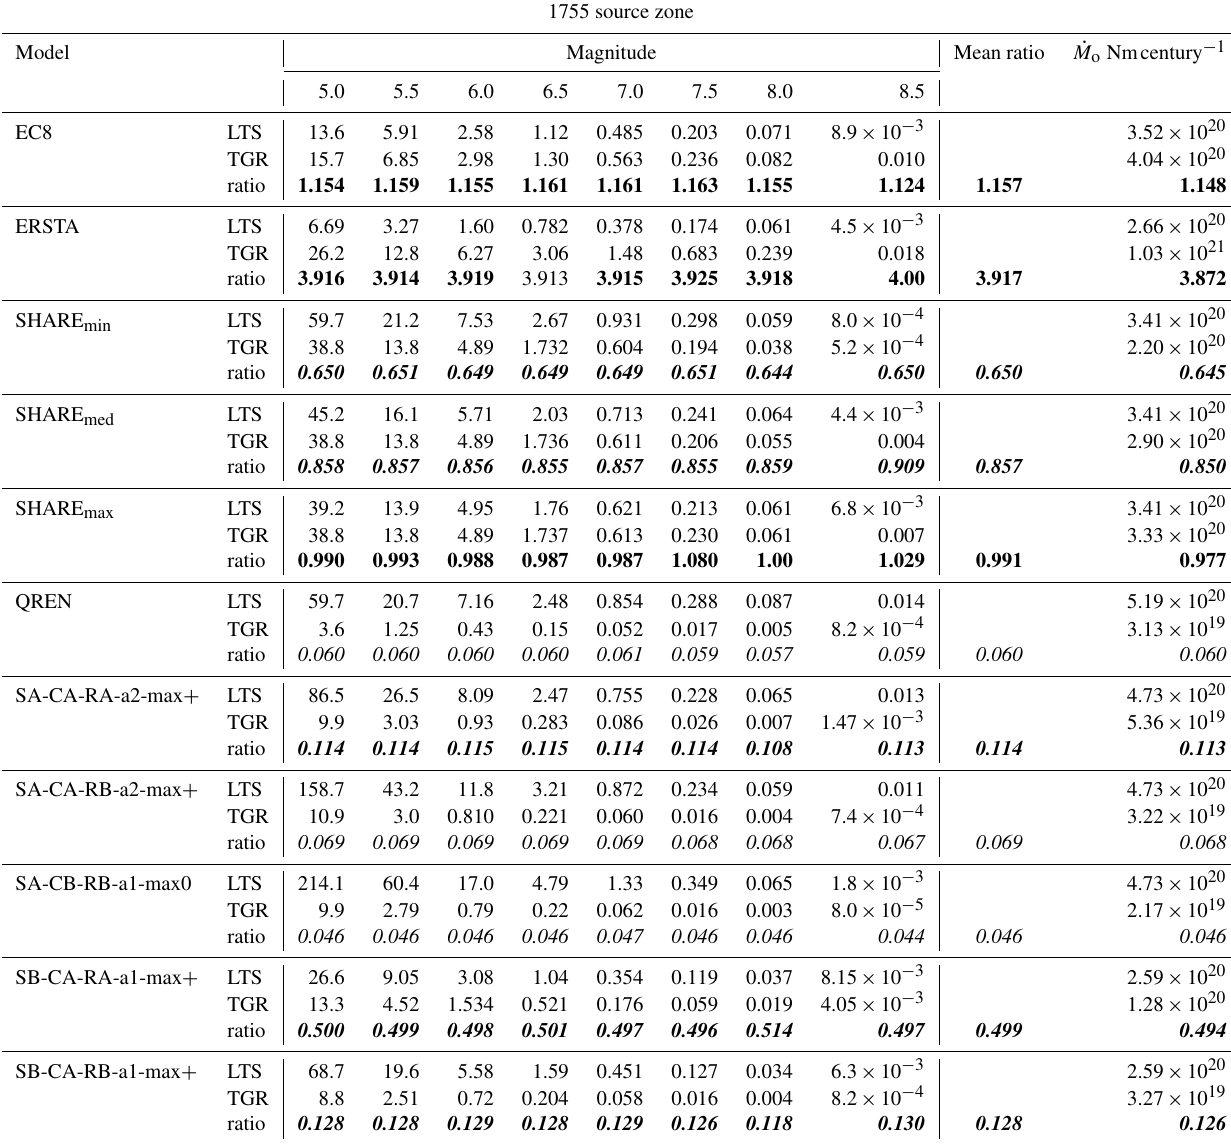
Table 11. Complex test: activity rates in earthquakes per century for the 1755 source zone. Two sets of seismicity parameters were used: (1) LTS obtained with the long-term seismicity program and (2) PSHA models expressed as tapered Gutenberg–Richter laws (TGR). Ratio represents the ratio between TGR and LTS. The number of earthquakes consider a catalogue period of 100 years. Ratios suspected to be too high are in bold and too low in italic. Acceptable ratios are in bold and italic. ˙ M 0 is the long-term seismic moment